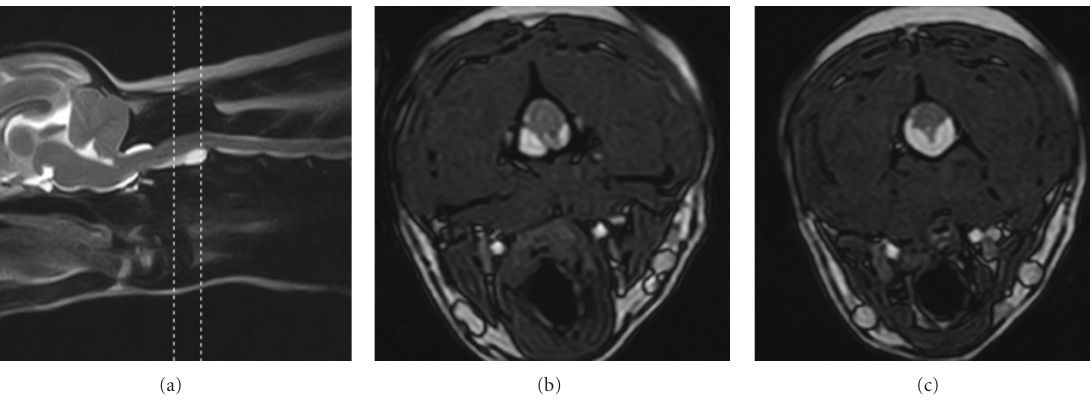
Figure 1: (a) Sagittal T2-weighted MR image showing a hyperintense cyst compressing the spinal cord. The vertical dotted lines indicate the level of the transverse images: middle image (cranial line) and right image (caudal line). (b) Transverse BASG at the level of the atlantoaxial joint demonstrating the cyst’s origin from the right side of the atlantoaxial joint. (c) Transverse BASG at the caudal aspect of C2 showing the biconvex outline and ventral bilateral location of the cyst eliciting severe compression of the spinal cord.